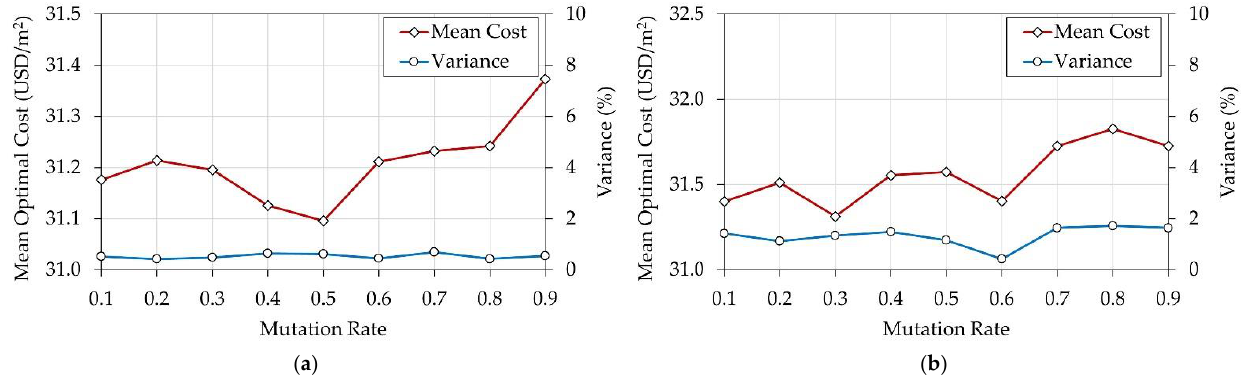
Figure 11. Effects of mutation rate on mean optimal cost: ( a ) FSWD; ( b ) FP.